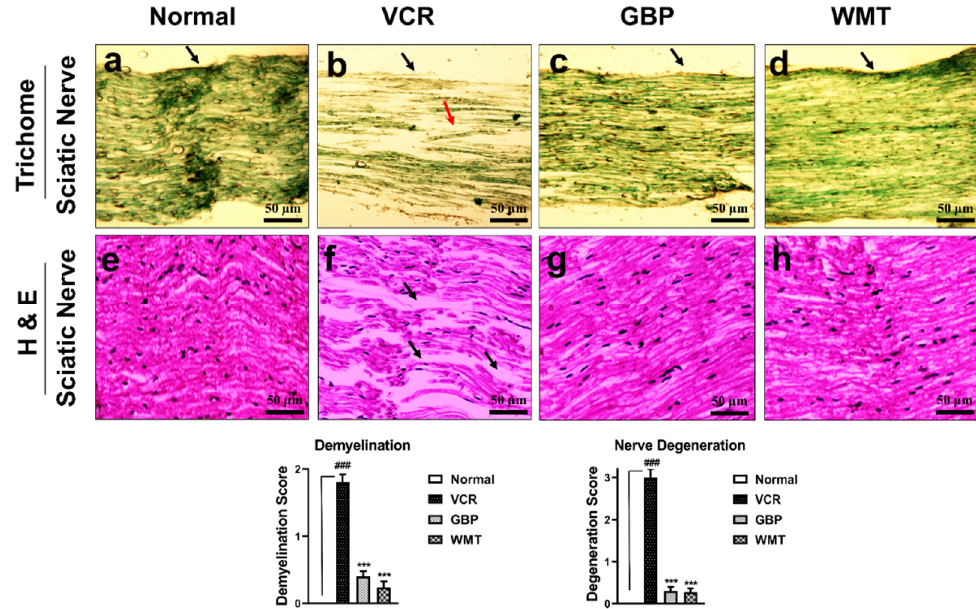
Figure 6. Effect of withametelin on the histopathological changes in the sciatic nerve (H&E and Trichome staining 10×). Representative photomicrographs of the sciatic nerve. Normal ( a , e ), VCR ( b , f ), GBP ( c , g ), and WMT ( d , h ). WMT and GBP inhibited histopathological alterations in the sciatic nerve. In ( a ), the black arrowhead shows a normal myelin sheath and normal fiber arrangement. In ( b ), the black arrowhead shows demyelination, and the red arrowhead shows fiber derange- ment. While ( c , d ) show recovery in the fiber derangement and demyelination. Similarly, in ( f ), the black arrowhead shows nerve derangement/degeneration and axonal swelling. While ( g , h ) show recovery in the nerve derangement/degeneration and axonal swelling. All results were expressed as the mean ( n = 3) ± SD. ### p < 0.001 compared to the normal control group; *** p < 0.001 compared to the VCR